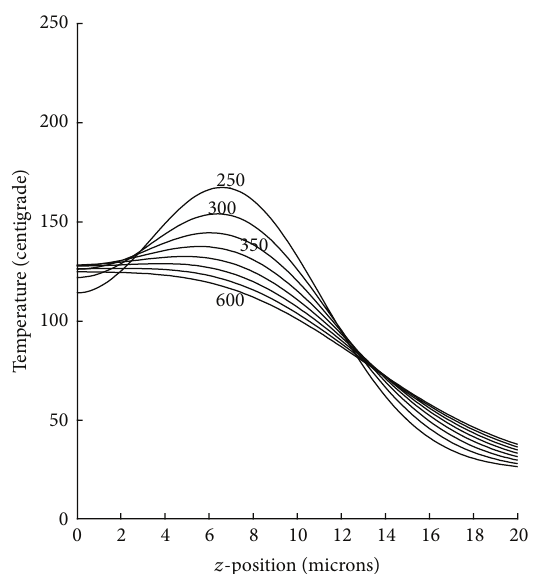
Figure 7: Temperature profiles on 𝑥 = 2.5 𝜇 m, 𝑦 = 0 , and V = 0.5 as a function of 𝑧 at times 250, 300, 350, 400, 450, 500, 550, and 600 𝜇 s.